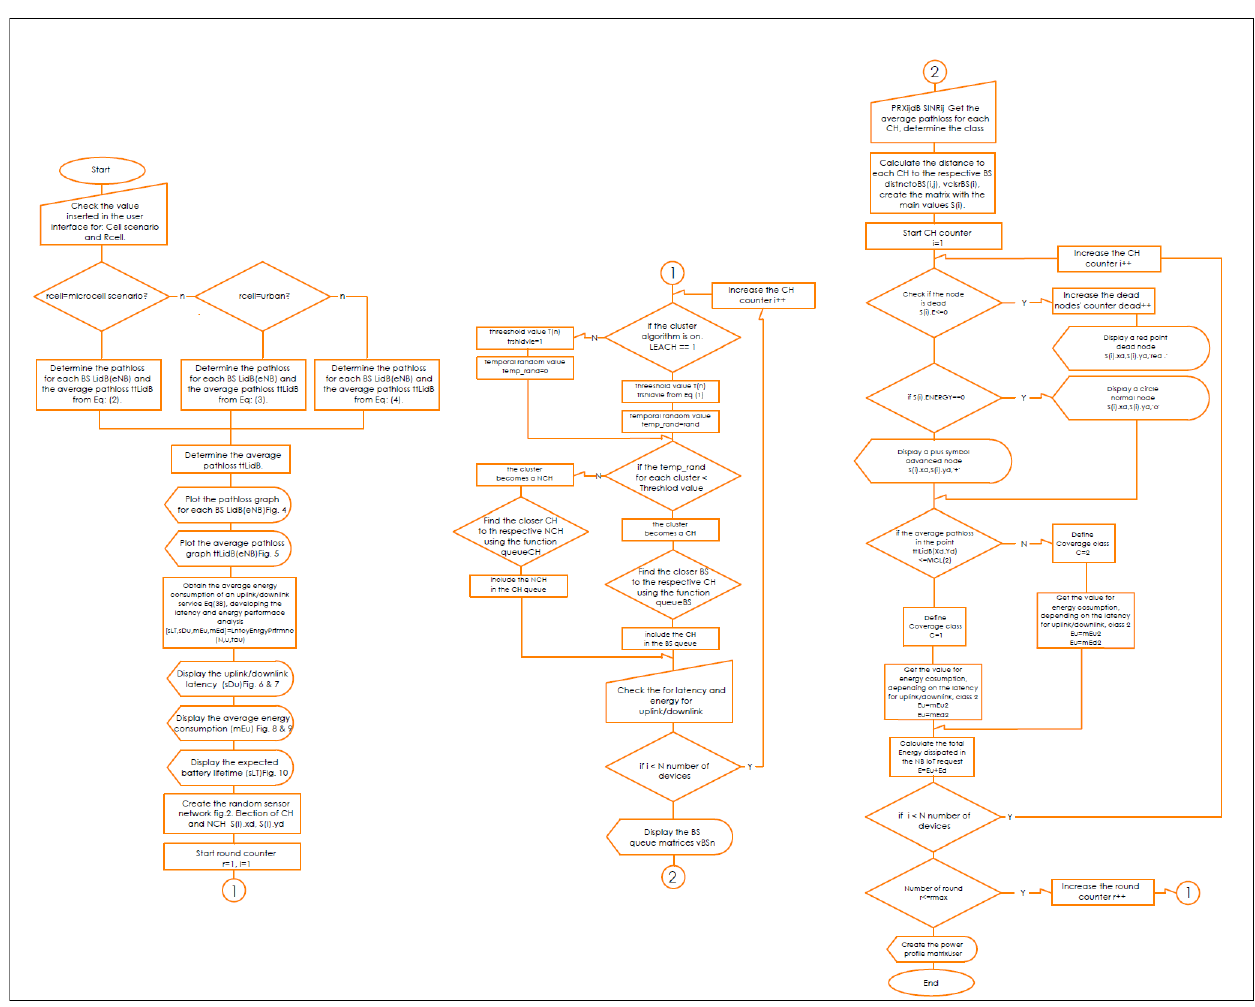
Figure 3. Flowchart of the MATLAB-based NB-IoT D2D